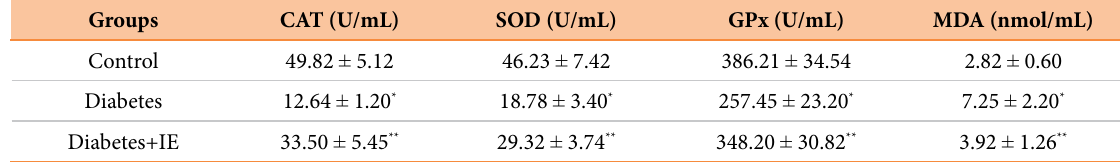
Table 3 – Levels of testis CAT, SOD, GPx and MDA in all groups.